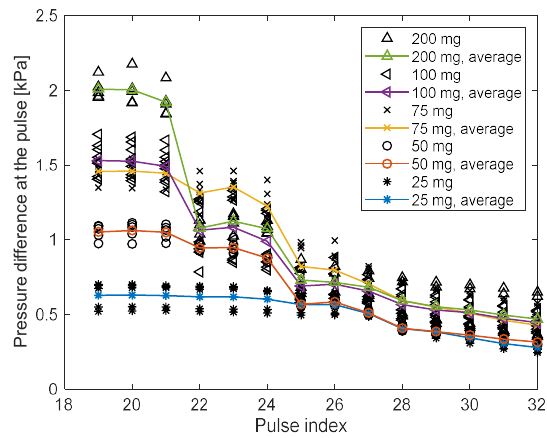
Figure 14. Maximum pressure at the pulses while reducing the duty cycle.